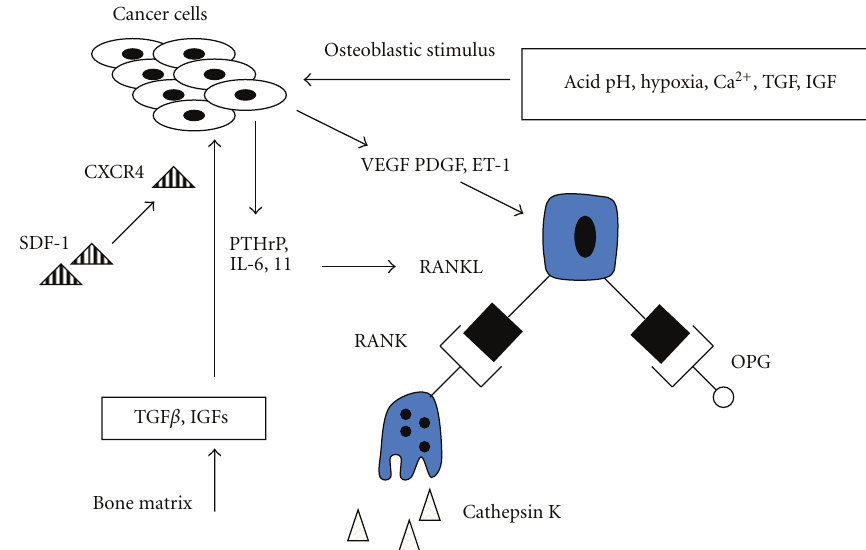
Figure 2: Vicious cycle of osteolysis by